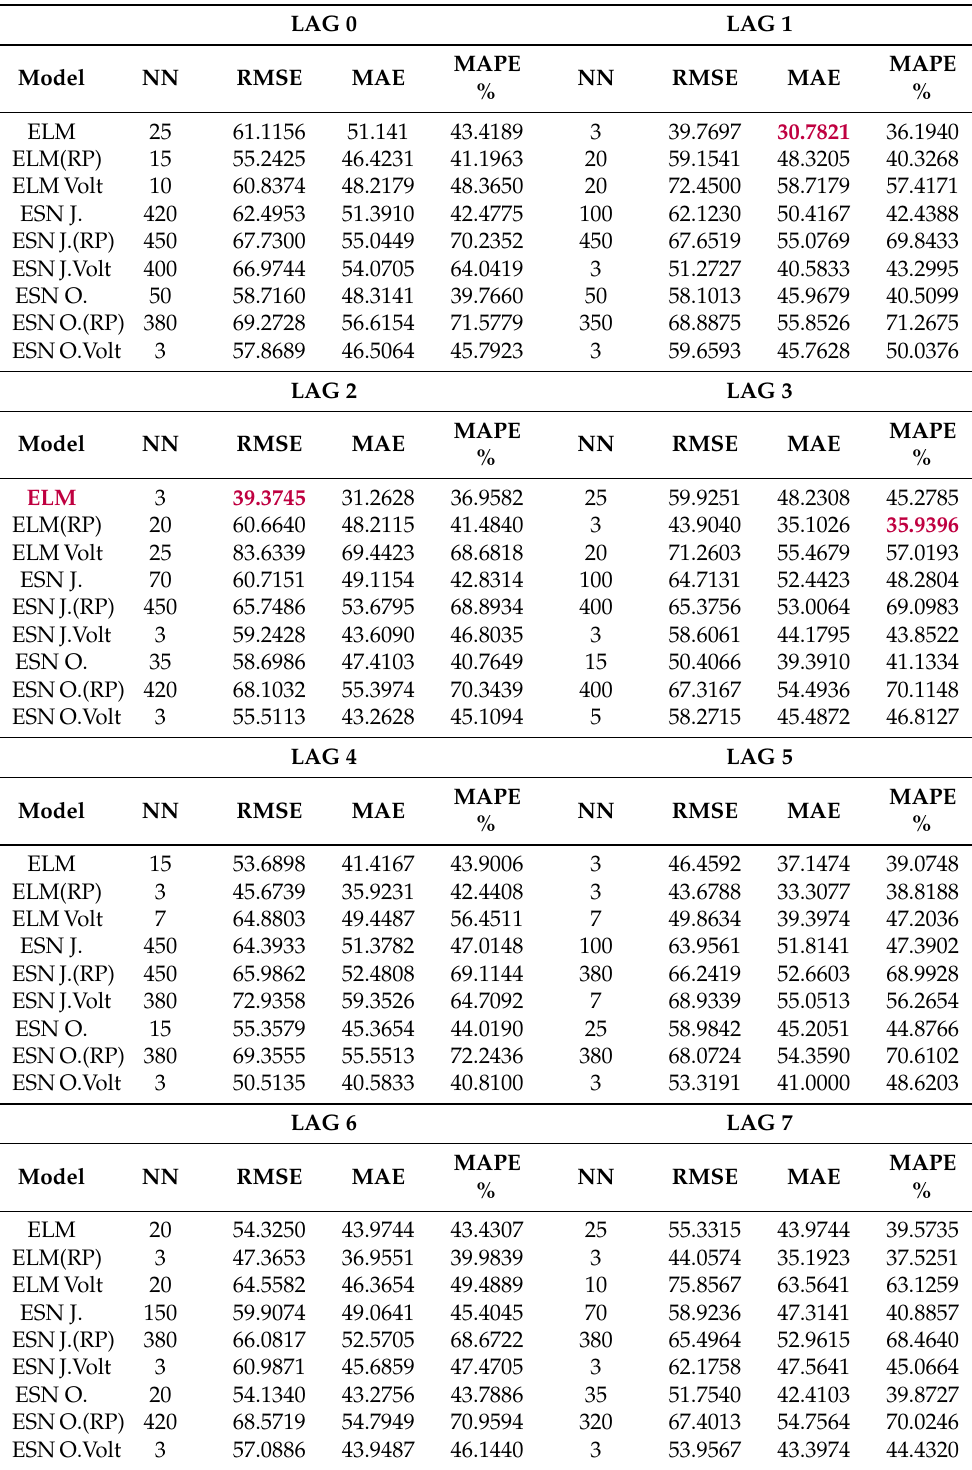
Table 5. Results for São Paulo (Number of neurons-NN, RMSE, MAE and MAPE for each model and